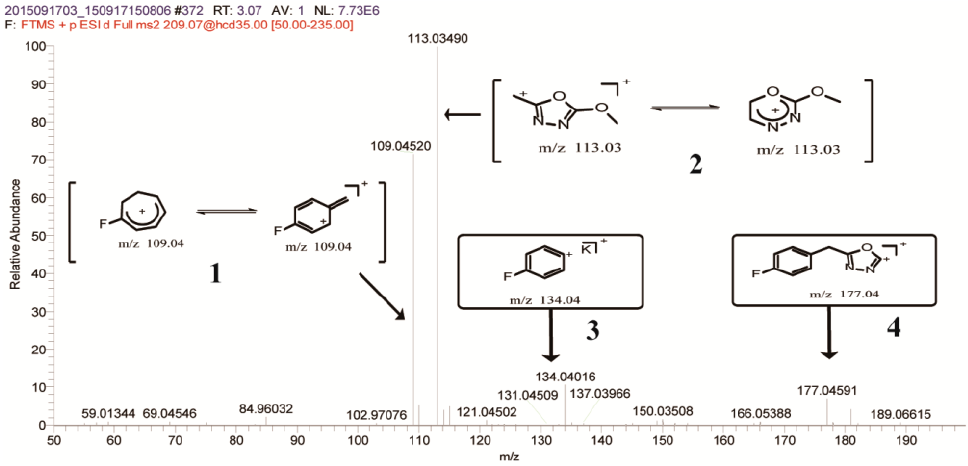
Figure 6. Mass spectrum of MS 2 of P 1 at m / z 209.07236.